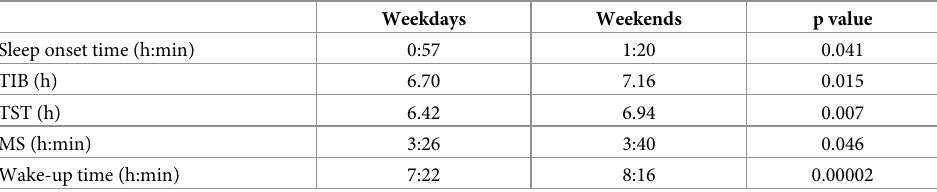
Table 2. The differences in sleep parameters between weekdays and weekends. Weekdays Weekends